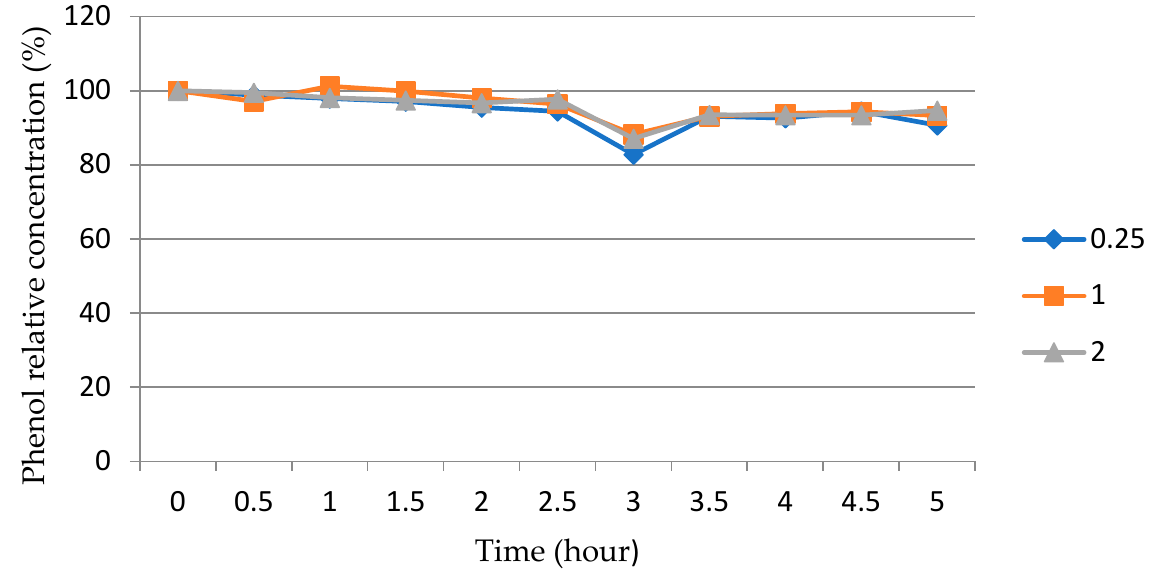
Figure 10. The dependence of the relative concentration (%) of phenol (C/C 0 ) on the time (h) under the dark regime in an aqueous solution in contact with ZnO particles sinthesized at different φ (numbers at the line designations) after calcination at 650 °C for 1 h.